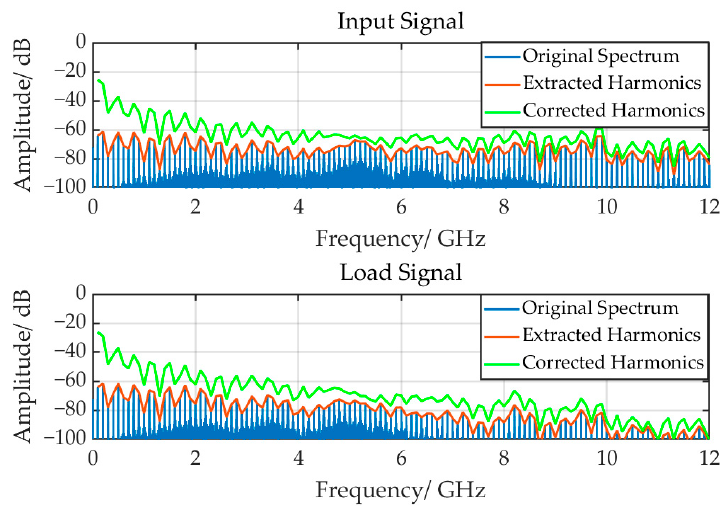
Figure 8. Amplitude of original, extracted, and corrected harmonics of the input and load signals.